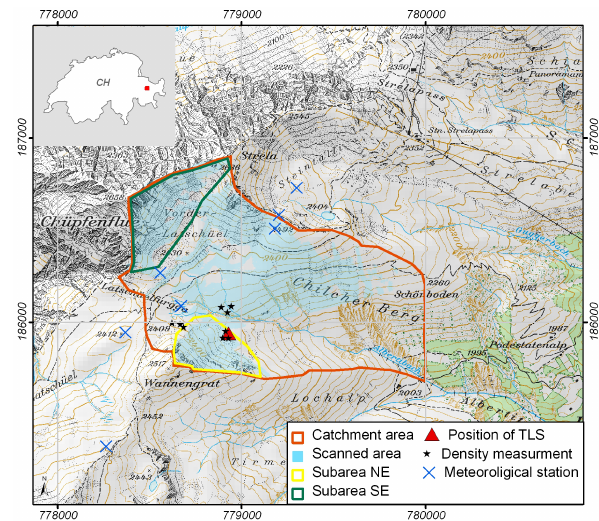
Fig. 1. Location of the Albertibach catchment (marked with the red line), the sub-areas NE (yellow line) and SE (green line), the area scanned in the TLS surveys (blue), the position of the TLS (red triangle) and of the meteorological stations in the area (blue crosses). Black stars indicate the position of the density samples taken at 26 April 2008. (base map: Pixelkarte PK25 © 2009 swis- stopo